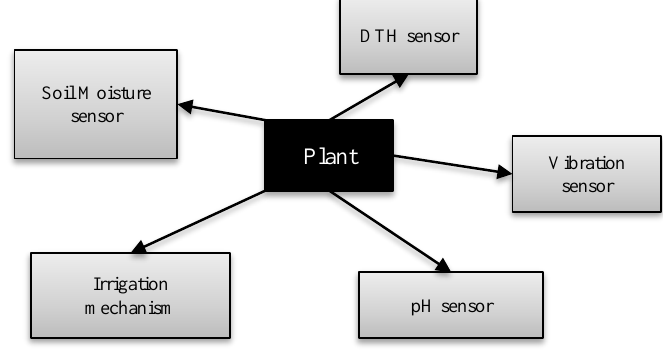
Figure 1. Plant monitoring